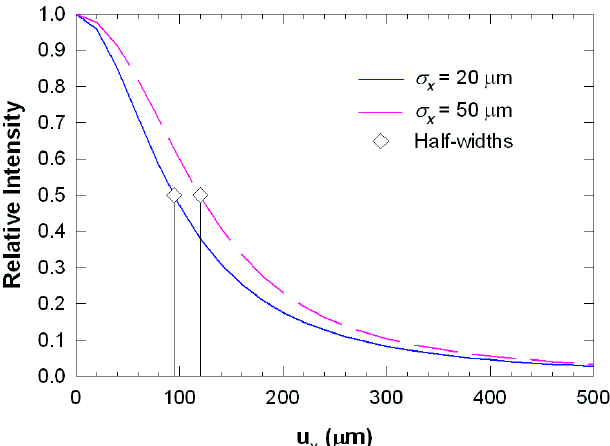
FIG. 12. (Color) Analytical results for the change in unpolar- ized, horizontal ODR profiles for a change in beam size from 20 to 50 (cid:2) m while holding the y value constant at 20 (cid:2) m . The impact parameter is 100 (cid:2) m for the 7-GeV beam. This is relevant to XFEL beam-size monitoring and other advanced